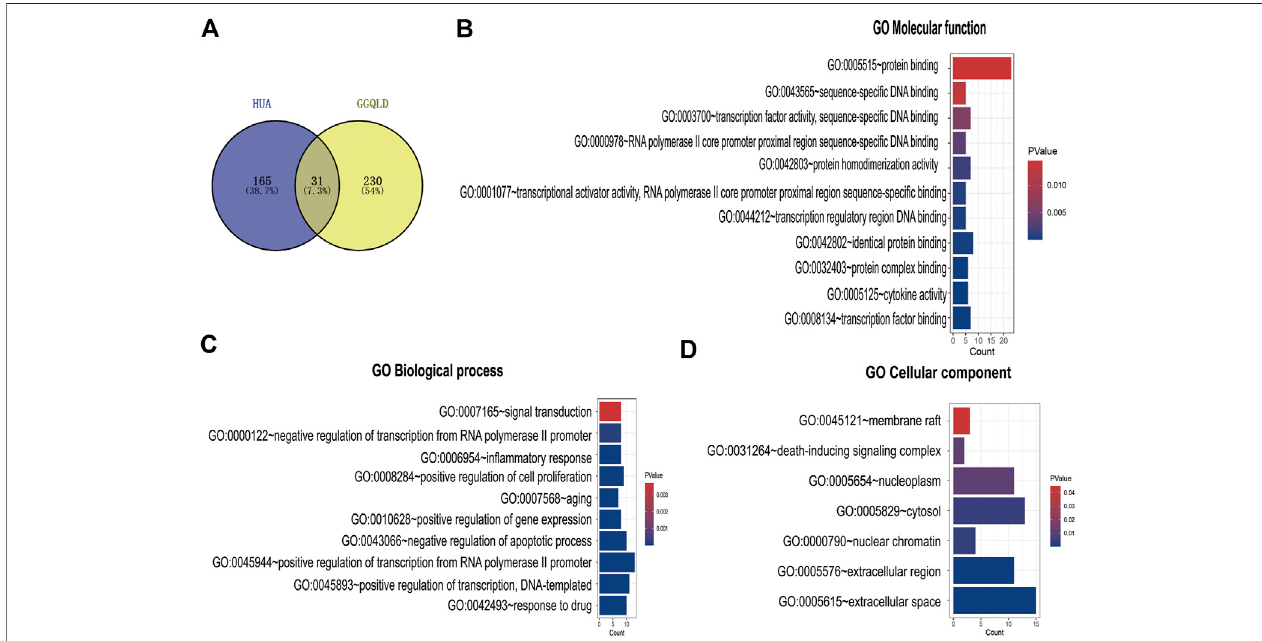
FIGURE1| GOenrichmentanalysisofthecommon targets. (A) TheVenndiagram ofboth GGQLD targets andHUA targets. (B) GOmolecularfunctionanalysisof overlapping targets. (C) GO biological process analysis of overlapping targets. (D) GO cellular component analysis of overlapping targets.